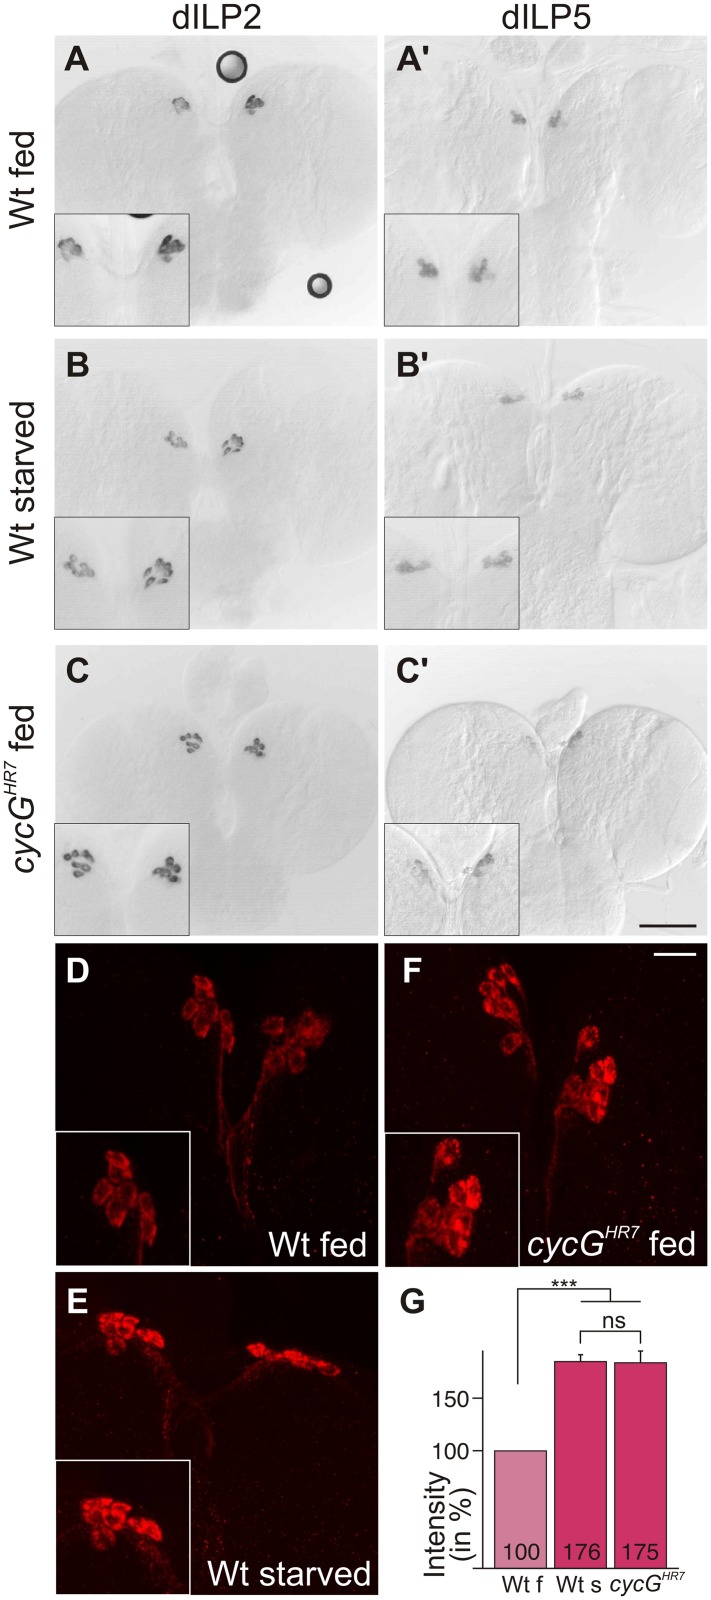
Disturbed dILP accumulation in cycG
HR7 mutant larvae.(A-C) Expression of dILP2 mRNA in the IPCs of larval brains was examined in fed (A) and starved (B) wild type (Wt) and fed cycG
HR7 mutant larvae (C). There was no apparent difference. (A’-C’) In well-fed wild type larvae (A’), mRNA expression of dILP5 is notably stronger than in starved larvae (B’) [34]. In the well-fed cycG
HR7 mutant larvae, dILP5 expression was very weak (C’). (D-F) Under starvation conditions, DILP2 protein accumulates in IPC bodies (compare D, Wt fed with E, WT starved). A similar enrichment was observed in well-fed cycG
HR7 mutant larvae (F). Scale bars: (A-C') 50 μm; (D-F) 10 μm. Insets in A-F show enlargements of IPCs. (G) Staining intensity of IPC groups was measured in fed wild type (Wt f) [n = 10], starved wild type (Wt s) [n = 6] and fed cycG
HR7 homozygotes [n = 18]; fed wild type was taken as 100%. Note similar levels of dILP2 enrichment in starved wild type and fed cycG mutant larvae. Error bars denote standard deviation. ***p<0.001; ns: not significant according to Student’s T-test.